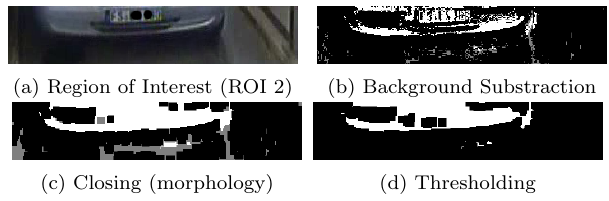
Figure 2: Preprocessing before using contour finding process